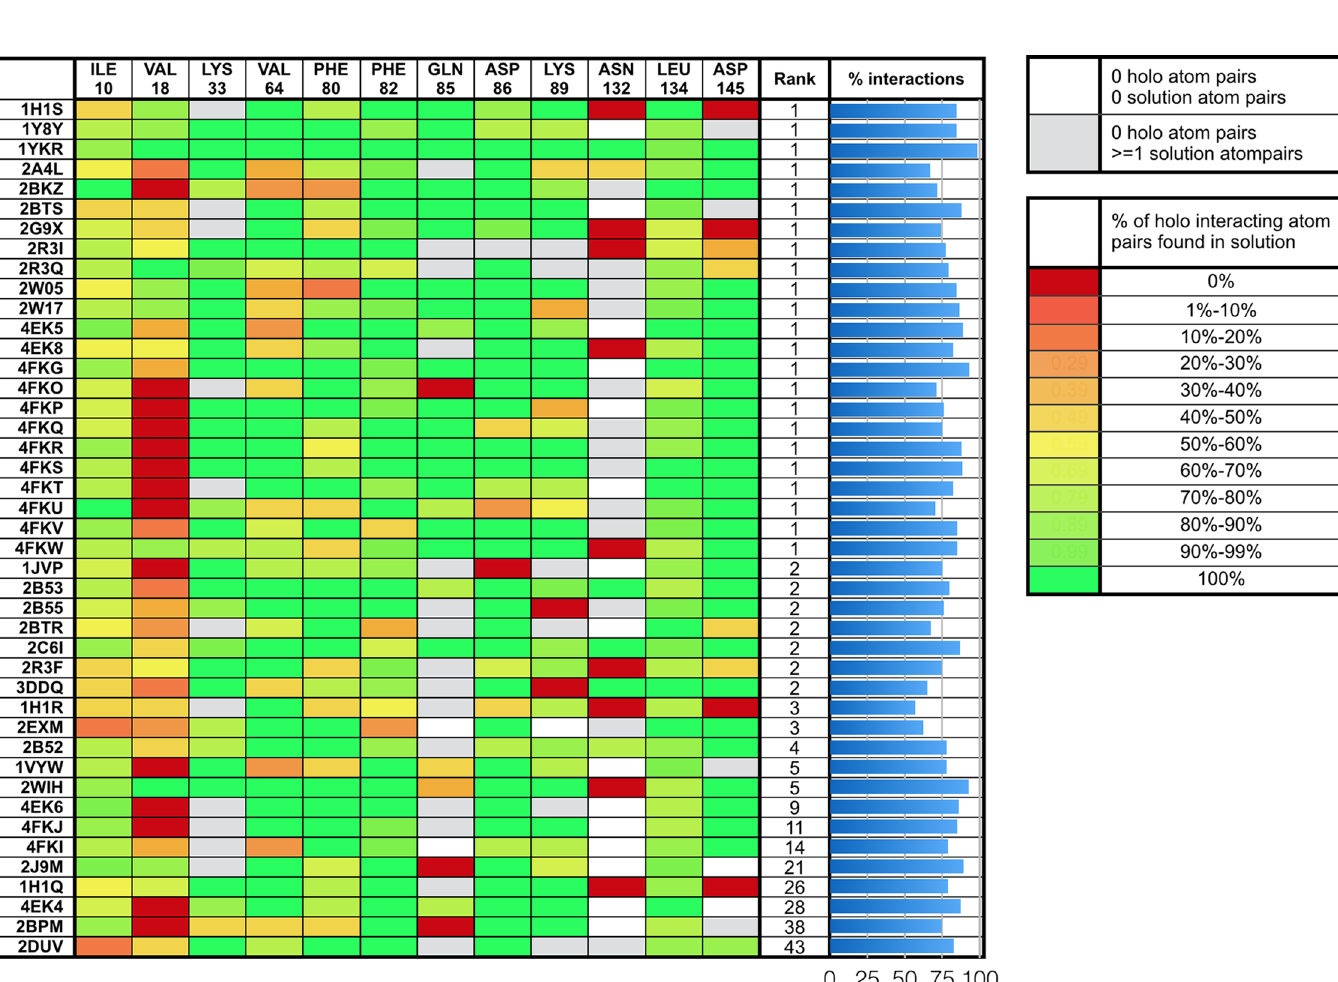
Fig 9. Heat map of ligand-flexible receptor atomic contacts reproduced in docked poses. The 43 systems reported in this table are the ones for which ADFR correctly reports the docked solution (i.e. ligand RMSD < 2.5 Å ). The rank of the solution among 50 GA runs is reported. White cells correspond to flexible side-chains not interacting with the ligand in either the holo or the docked complex. Grey cells indicate interactions formed in the docked solution, which do not exist in the holo complex. The remainder of the cells is colored using a red to green color scale indicating the percentage of holo interacting atomic pairs reproduced by the docked solution. A green cell (rate of 100%) indicates that every pairwise atomic interaction between ligand atoms and the side-chain atoms of the residue corresponding to that cell are reproduced in the docked solution. The histogram displays the percentage of holo interactions that are reproduced across all 12 side-chains for every ligand. The ligand reproduced at least 57.1% of all the interacting pairs in the holo complex, with an average of 79.8%